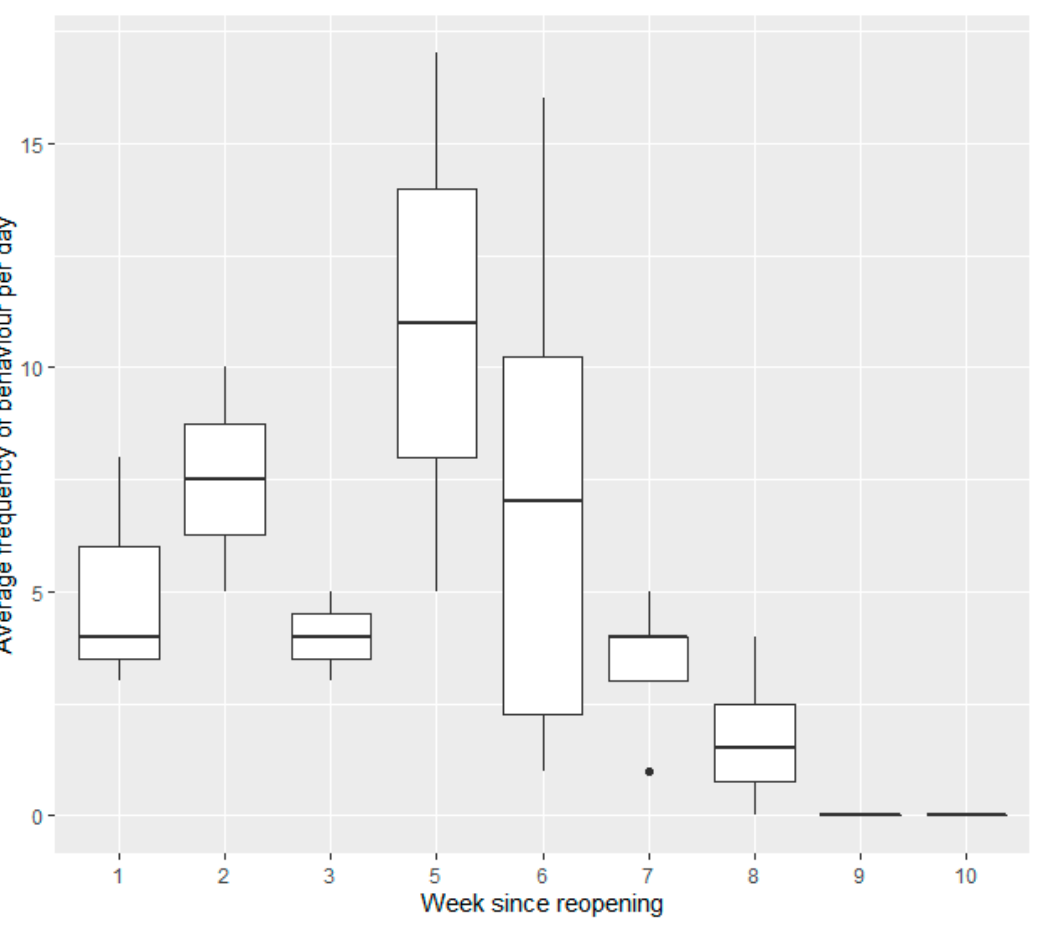
Figure 10. Average frequency of environmental interactions recorded in the meerkats at Dartmoor Zoo per day in the weeks since the facility reopened to the public. Dots represent outliers.